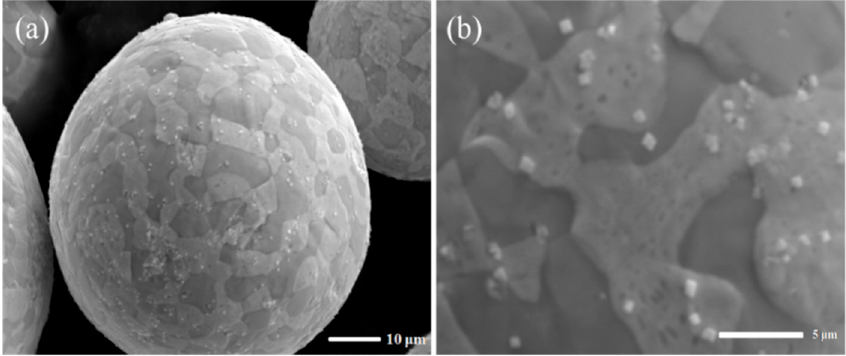
Figure 7. SEM images show the precipitate particles in the powders after aging at 150 °C for 3 days.